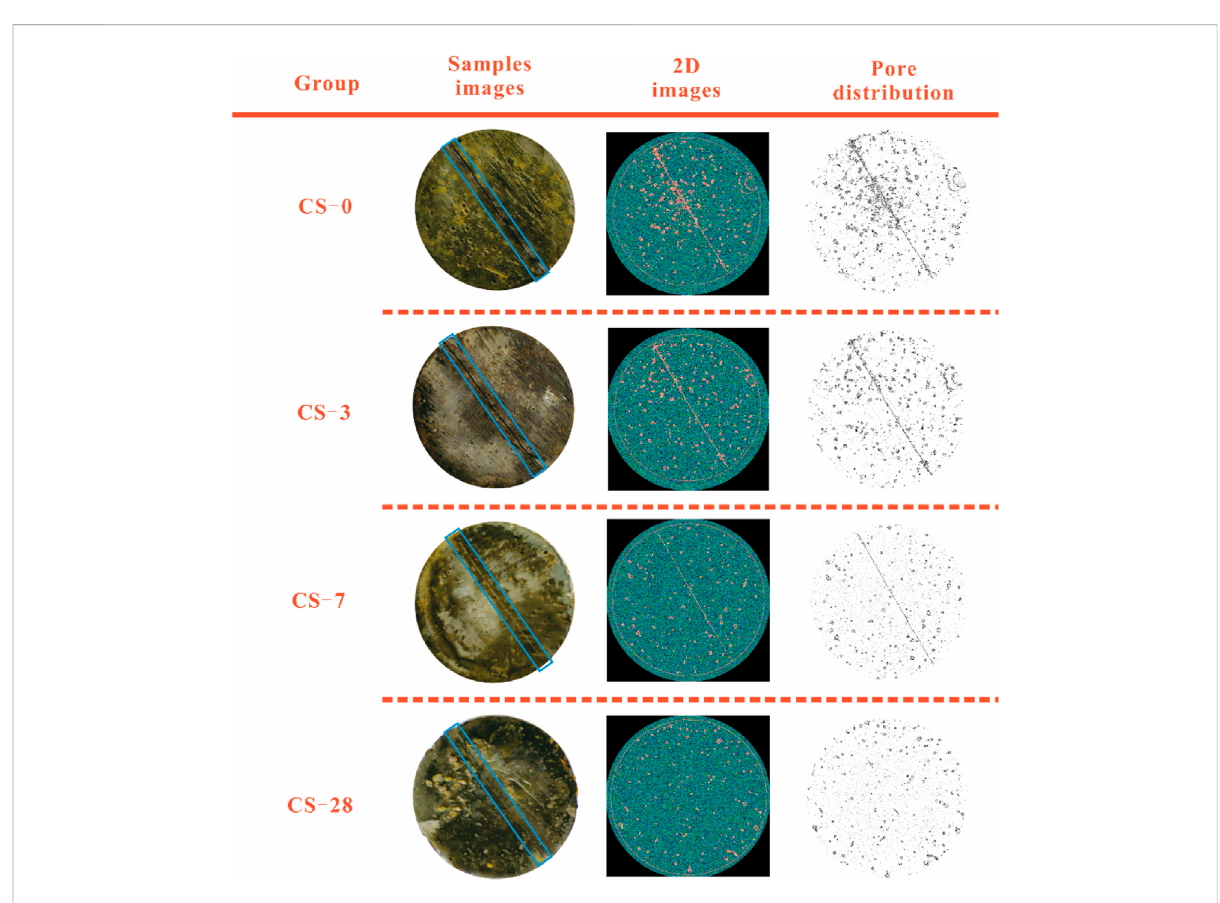
FIGURE 8 2D vertical section taken from the Z -axis of the CS